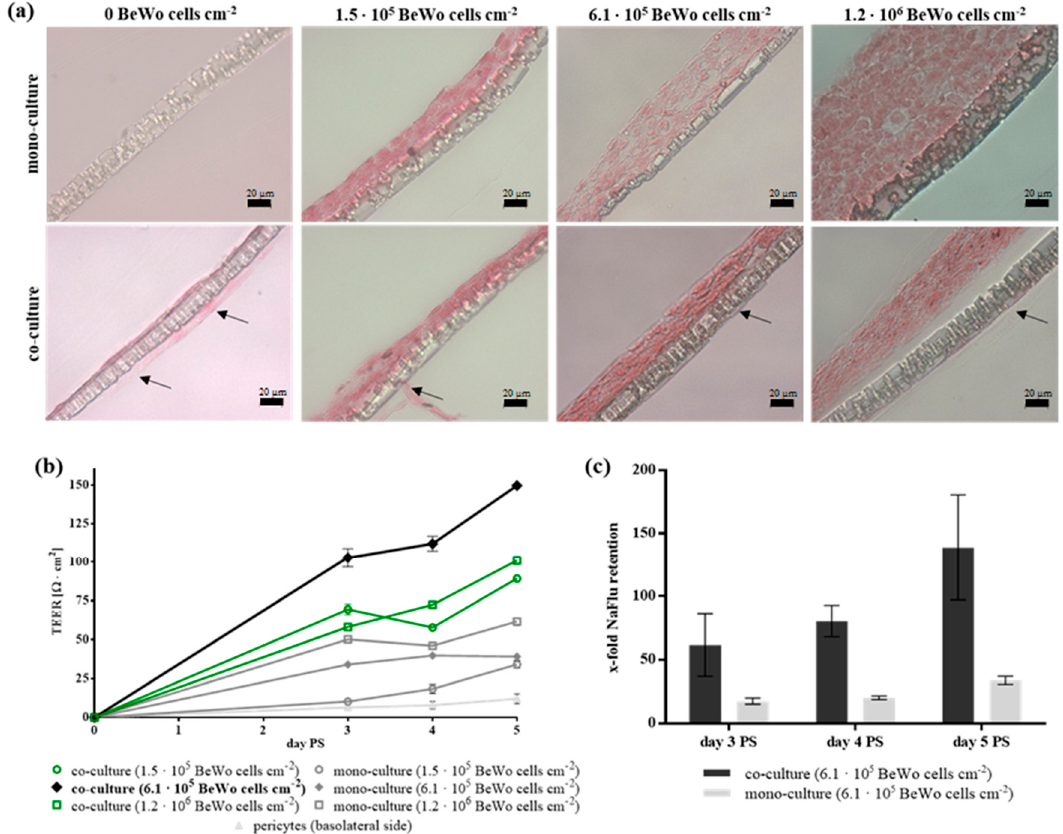
Figure 1. Establishment and verification of an in vitro blood-placenta barrier model. ( a ) Histological cross sections from co-cultures (BeWo, pericytes) and mono-cultures (BeWo) in dependence of the initial cell seeding number. On day five post seeding (PS), histologic cross sections of transwell membranes were stained with Nuclear Fast Red. Arrows mark the pericyte cell layer on the basolateral side of the membrane. Scale bar represents 20 µm. ( b ) The transepithelial electrical resistance (TEER) was measured for each condition in triplicates per insert on days three to five PS and corrected for values of cell-free inserts. Shown are mean TEER values ± standard deviation of three to nine inserts. ( c ) The passage of the permeability marker sodium fluorescein (NaFlu) through the barrier was measured in triplicates for each insert and the calculated permeability coefficients were normalized to blank membranes. For each condition, two replicate inserts were used. Shown are mean values of the x-fold NaFlu retention ± standard deviation of three measurements per insert for two replicate inserts.